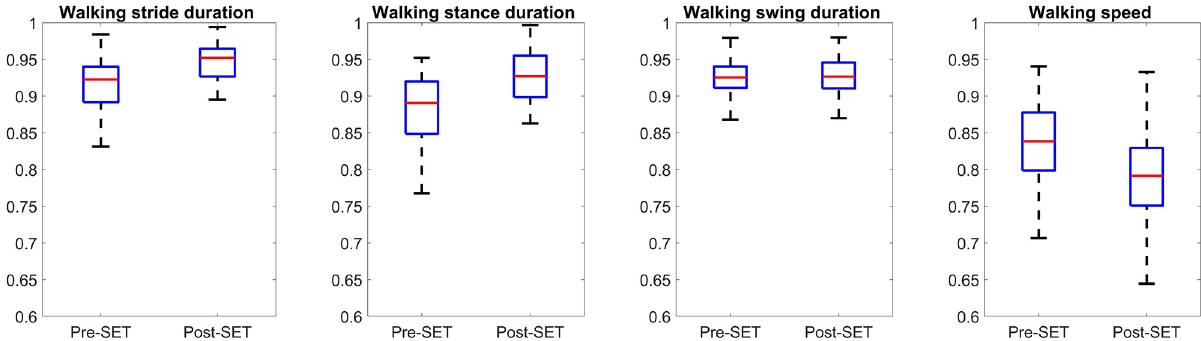
Fig 7. Comparison of speed and stride, stance, and swing duration features of all horses between pre- and post-SET during walk. The vertical axes of all plots represents the range-normalized value. The box represents the interquartile range, while the red line (horizontal line within the box) shows the median value. Each box (two for each plot) consists of one value per horse, which was averaged from all strides of the horse.